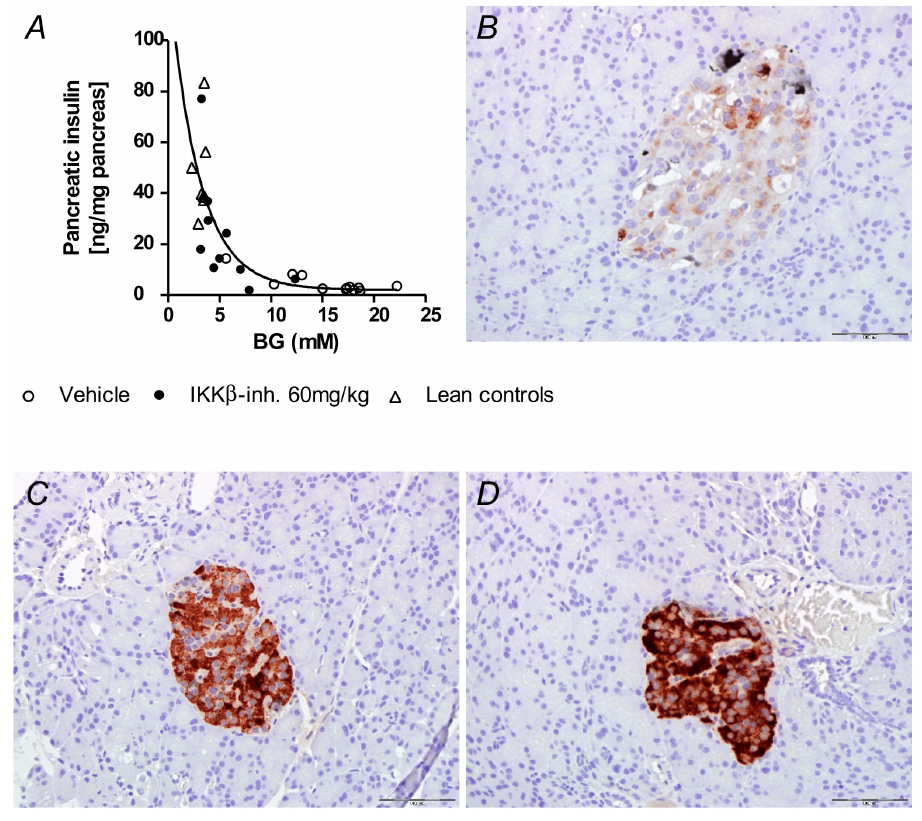
Figure 6. Effect of an IKK b -inhibitor on pancreatic insulin content in P.obesus . Diabetes-prone P. obesus , age of 13–14 weeks, were transferred from ad libitum low energy diet to ad libitum high energy diet. At the same day (day 0) treatment was initiated with vehicle or with the IKK b -inhibitor. A) Data shows blood glucose vs. pancreatic insulin content after 28 days of treatment with vehicle (open circles n=12) or with the IKK b -inhibitor (black circles n=10); and from age matched non-diabetic animals feed ad libitum low energy diet (lean control) (open triangles n=8). Immunostaining in reddish brown for insulin in tissue sections of pancreata from animals after 28 days of treatment with vehicle (B) or with the IKK b - inhibitor (C); and from a age matched non-diabetic lean control animal (D).